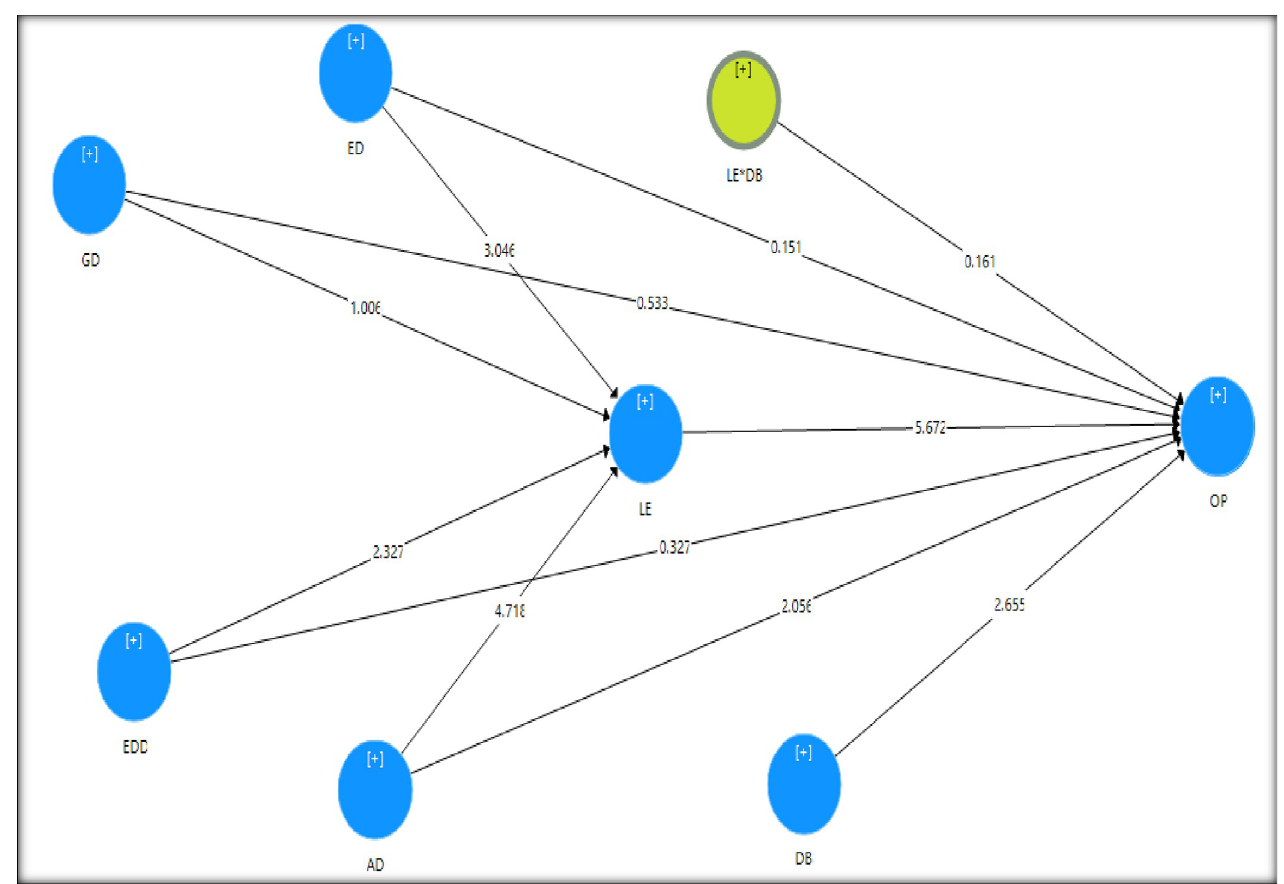
Fig 3. Bootstrapping result with inner